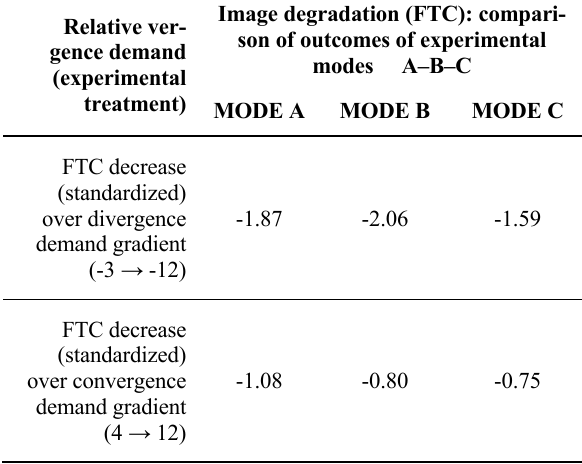
Relative ver- gence